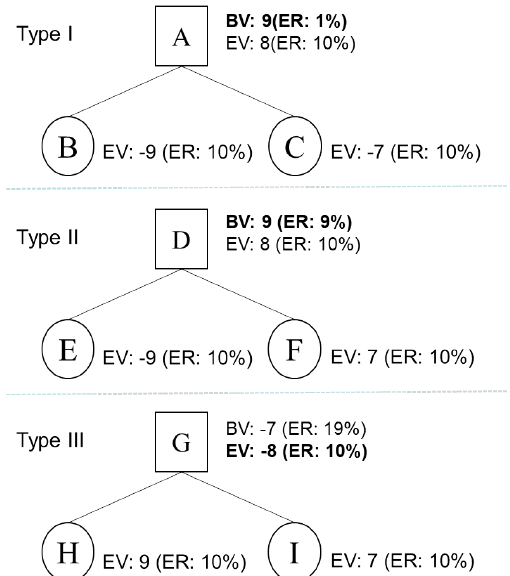
Figure 5. An instance of the error minimizing minimax (EMM)